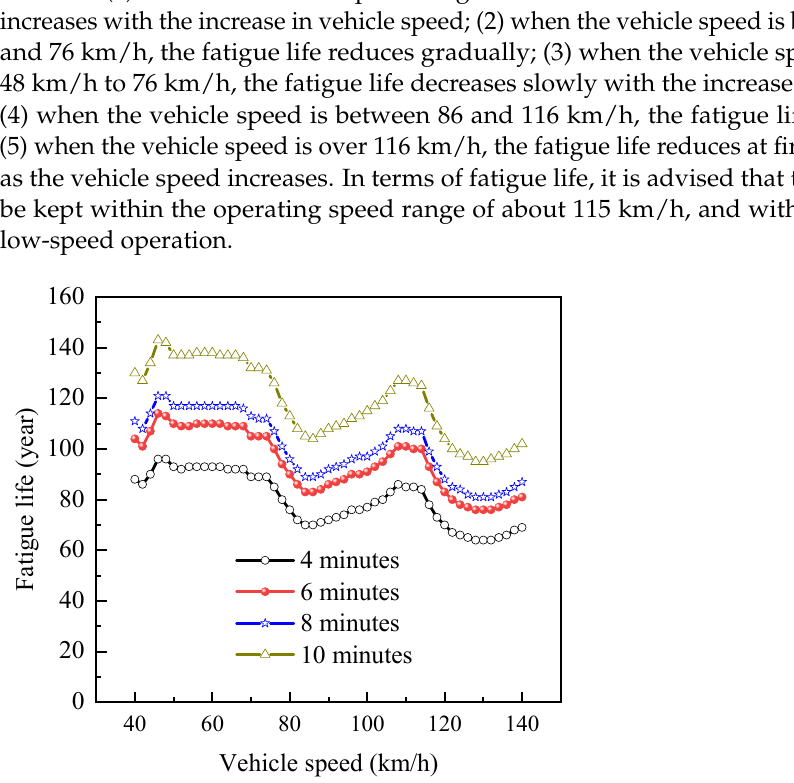
Figure 12. Fatigue of 25 m-span bridge under various vehicle speed.